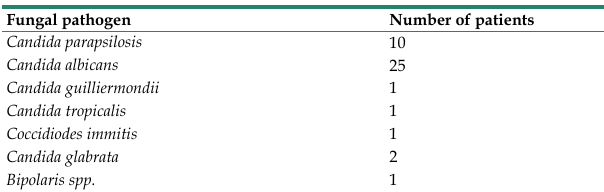
Abbreviation: PJI, prosthetic joint